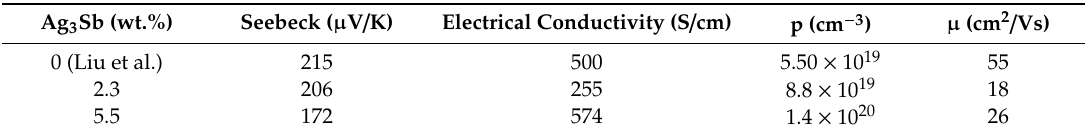
Figure 7. Comparison of ( a ) lattice thermal conductivity and ( b ) figure of merit for di ff erent dyscrasite contents. The samples were made by PBM. Calculated carrier concentration and mobility at room temperature for di ff erent dyscrasite